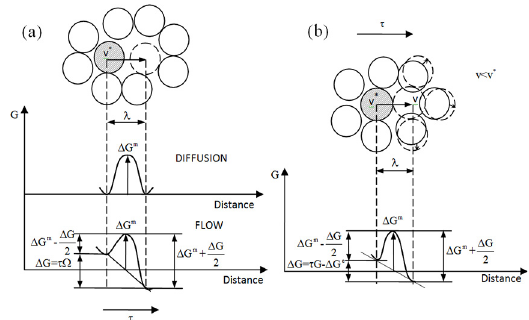
Figure 4. (a) Illustration of an atomic jump; (b) The creation of free volume. 73